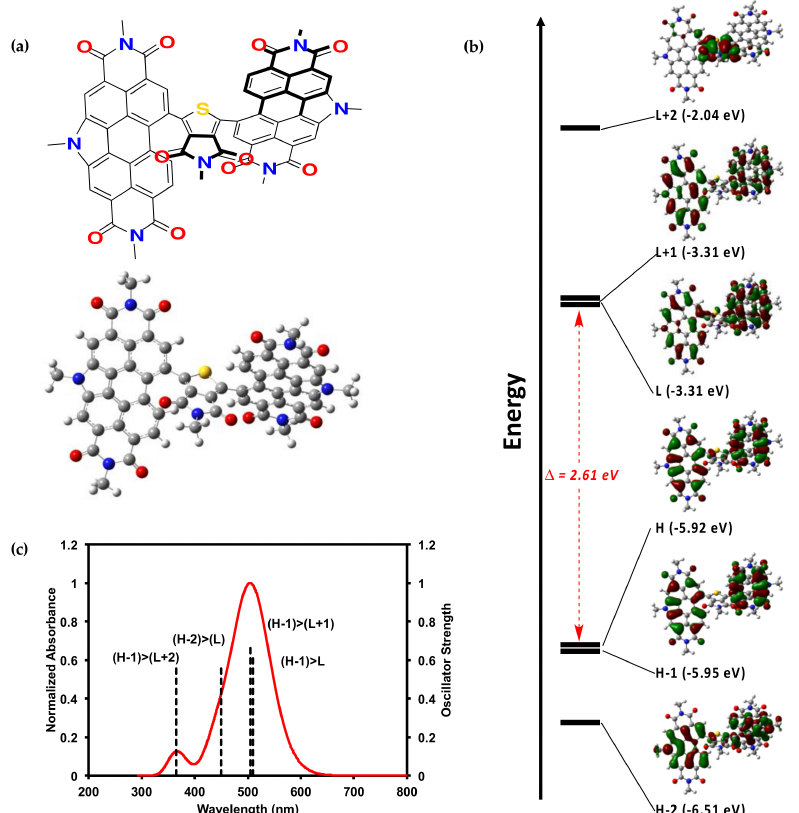
Figure 4. ( a ) Optimized geometry of 1 with methyl groups substituted for alkyl chains; ( b ) calculated electronic energy levels and energy gap for 1 ; ( c ) calculated optical absorption profile for 1 . Calculations were done on Gaussian16 [61], input files and results were visualized using GausView05 [62]. All alkyl chains were replaced with a methyl group. The B3LYP [51–53] level of theory with 6-31G(d,p) [54–59] basis set were used for the calculations. TD-SCF [60] calculations were performed from the optimized geometry. The single point calculation was performed on this structure in order to generate molecular orbitals and electrostatic potential